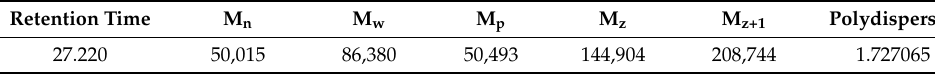
Table 1. GPC for chitosan sample after 60 min.